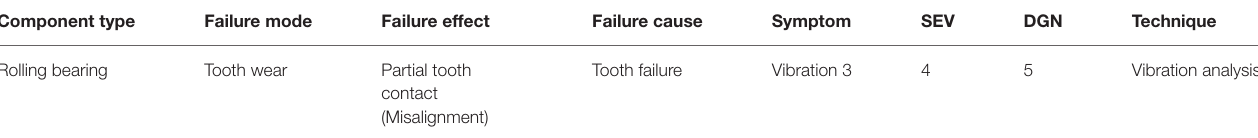
TABLE 8 | Query outcome for failure mode with highest